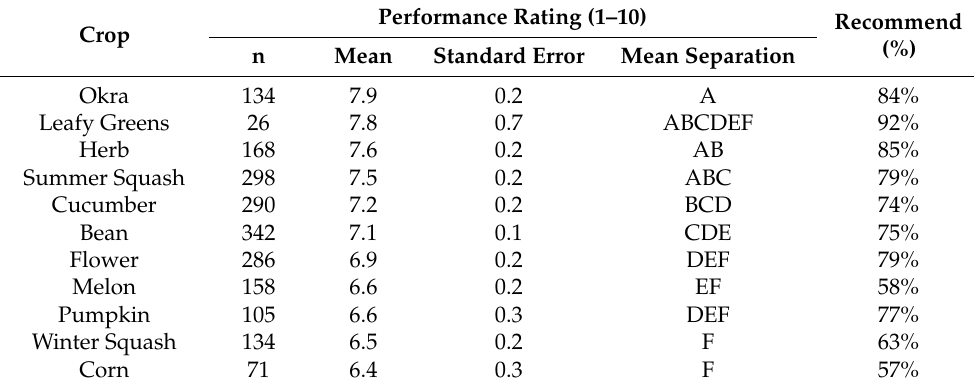
Table 9. Mean performance rating by crop for 2018–2020. Performance was rated on a scale of 1 to 10, with 1 indicating poor performance and 10 indicating excellent performance. The number of participants who returned usable data for each cultivar is reported as “n”. Mean separation was performed using Fisher’s Protected LSD with an alpha level of p <